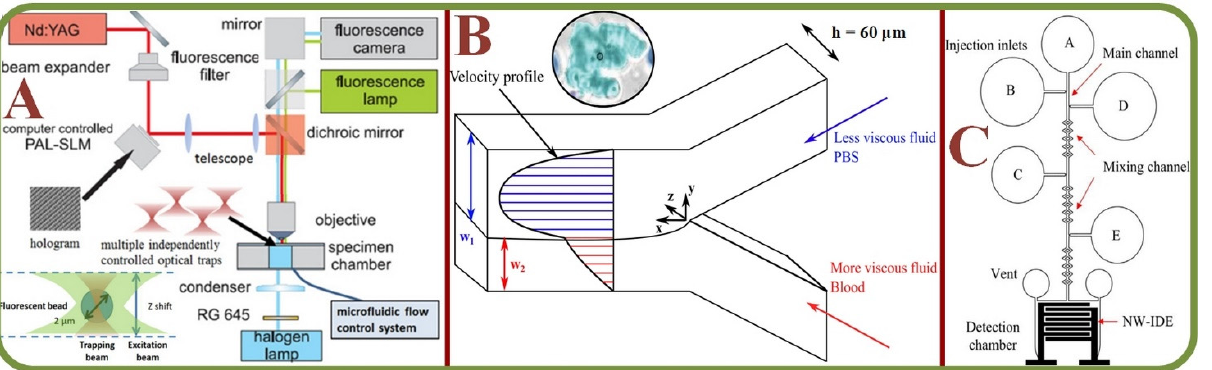
Figure 7. RBC Agglutination/Aggregation in microfluidic environment. ( A ) Laser tweezers combined with microfluidics for the single RBC dextran absorption study with the schematic layout of the holographic laser tweezer and diagram for fluorescence detection. [101]; ( B ) The RBC aggregation and the effect on non-Newtonian blood viscosity in a two-fluid low shear rate system. Inset: a sample of RBC aggregation with the “rouleaux” structure [105]; ( C ) The microfluidic chip structure of RBC agglutinations for the blood type detection [114].